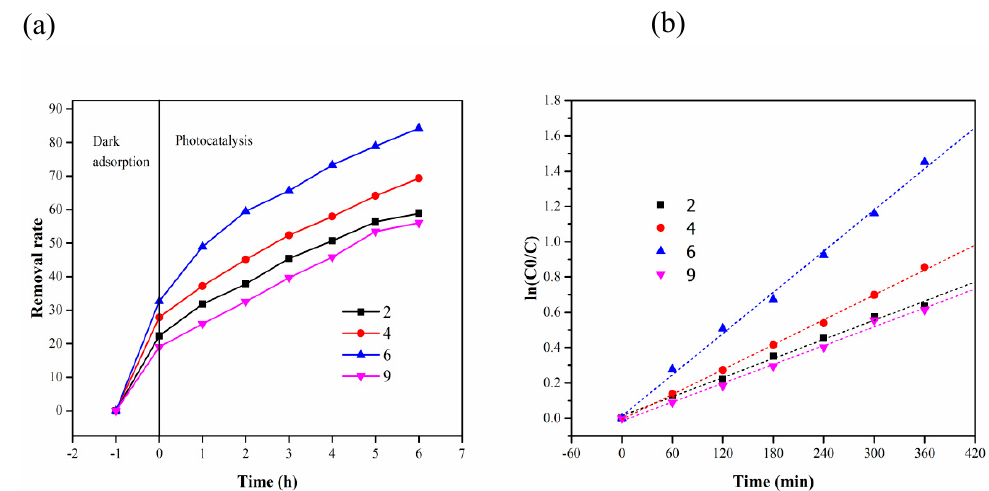
Figure 10. ( a ) Removal rate of MB at different pH; ( b ) kinetics of photocatalytic degradation of MB at different pH.